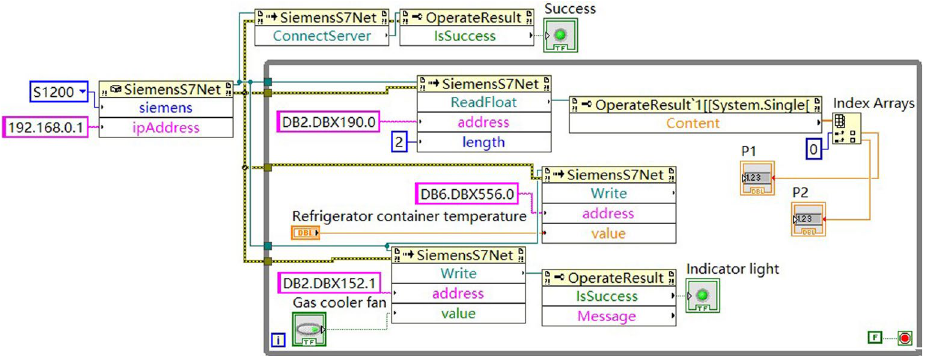
Figure 9. Part of the communication program in LabVIEW.